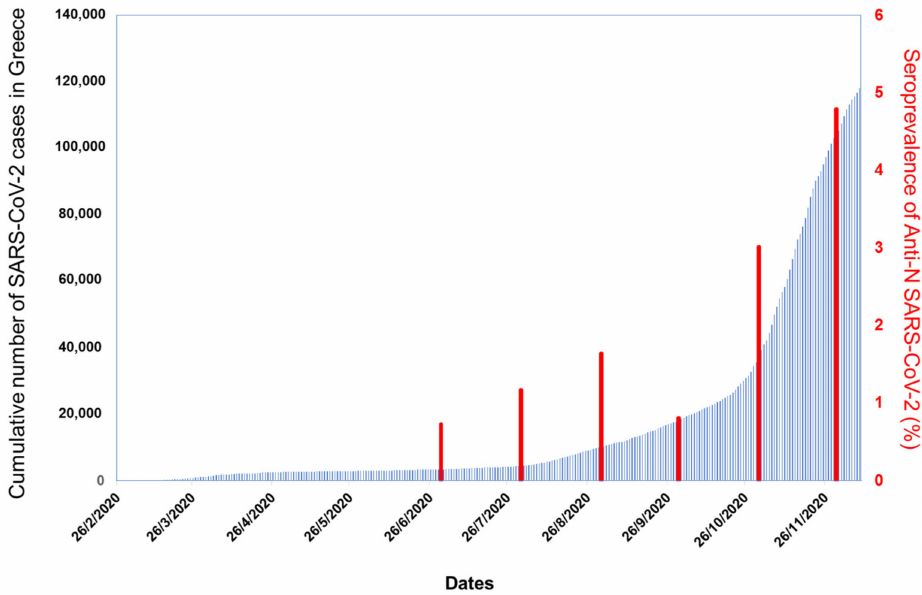
Figure 1. Seroprevalence of SARS-CoV-2 antibodies for each month of the survey and cumulative case counts per day in Greece. Blue bars show the cumulative number of SARS-CoV-2 cases recorded in Greece per day from 26 February to 4 December 2020. Red bars show the weighted seroprevalence for age and test performance estimated for the anti-SARS- CoV-2 N-protein per month (July–November) in the volunteer participants from the National and Kapodistrian University of Athens